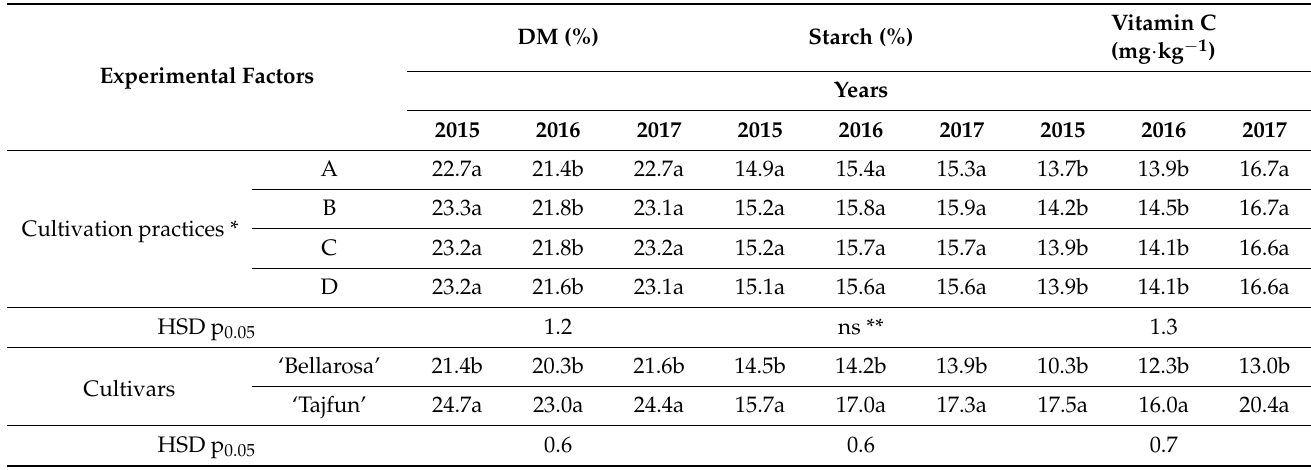
Table 10. Influence of cultivation practices, cultivars, and years on DM, starch, and vitamin C content.